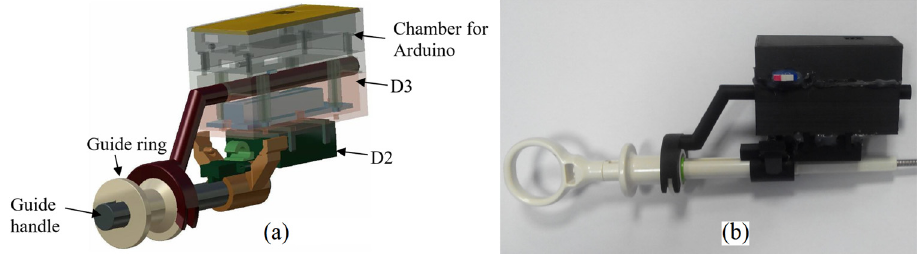
Figure 7. The guide handle rotation angle measurement device and the deflection of the guide tip. ( a ) Details of the housing unit. ( b ) The prototypes in their working condition.